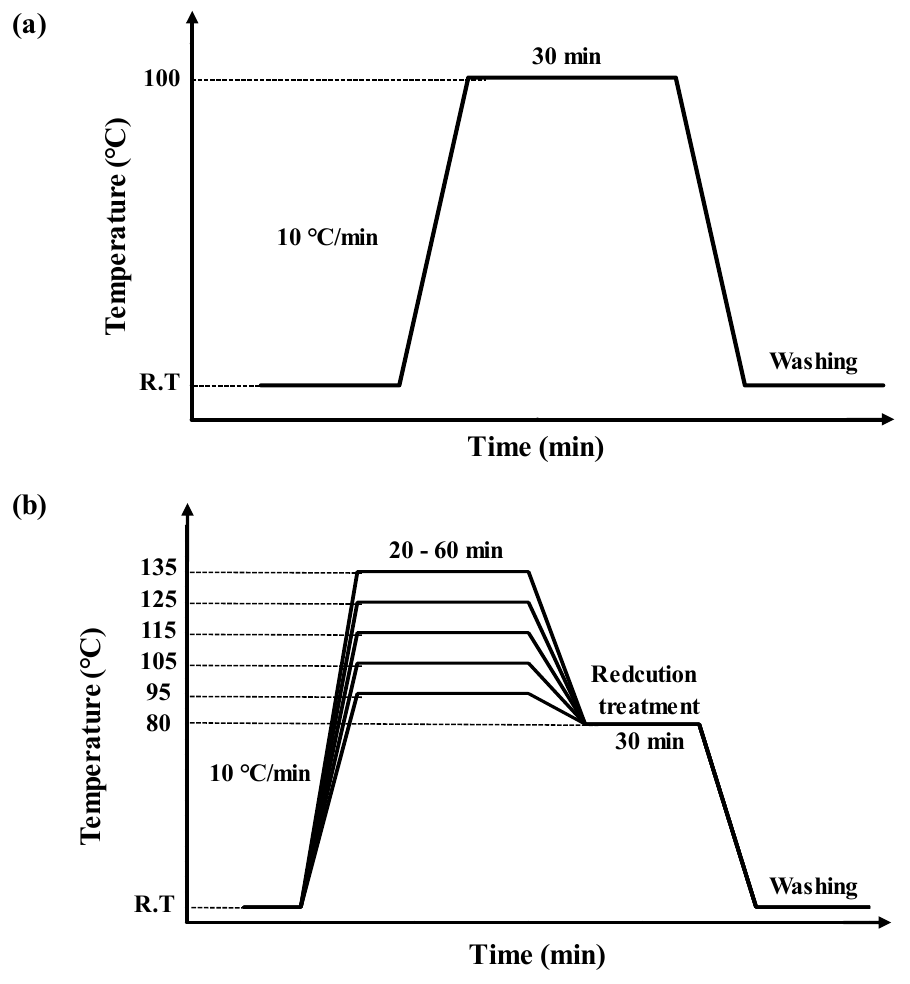
Figure 1. ( a ) Alkaline hydrolysis profile for various concentrations of NaOH. ( b ) Dyeing profiles of sea-island ultramicrofibers of PET tricot fabrics.